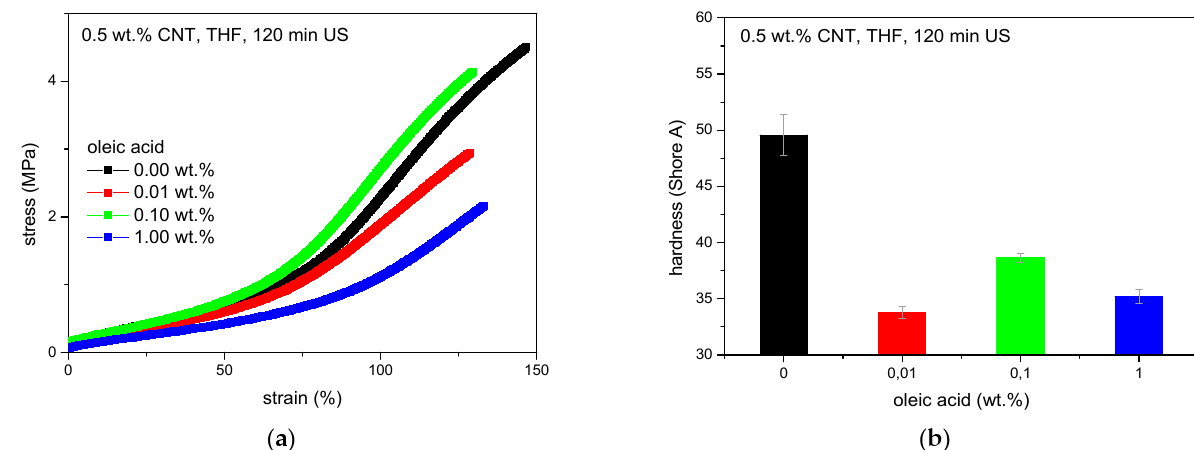
Figure 6. Results of mechanical experiments of composites pretreated with THF and oleic acid, ( a ) stress-strain curves and ( b ) Shore A hardness.